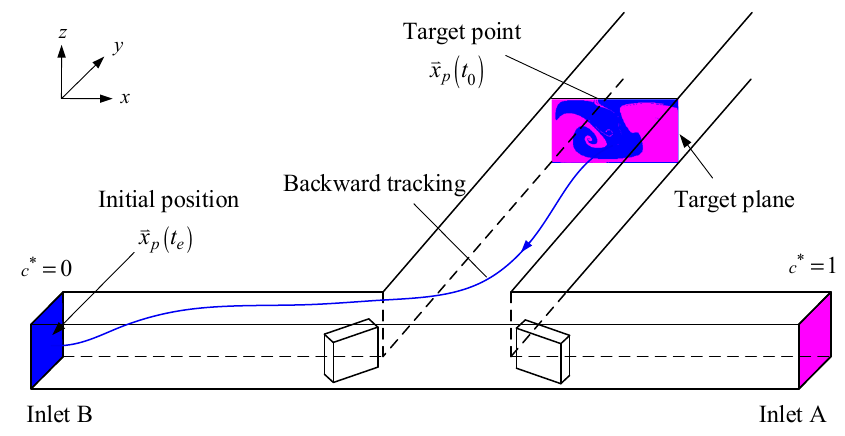
Figure 2. Three-dimensional (3D) micromixer geometry and the sketch of backward fluid particle tracking.